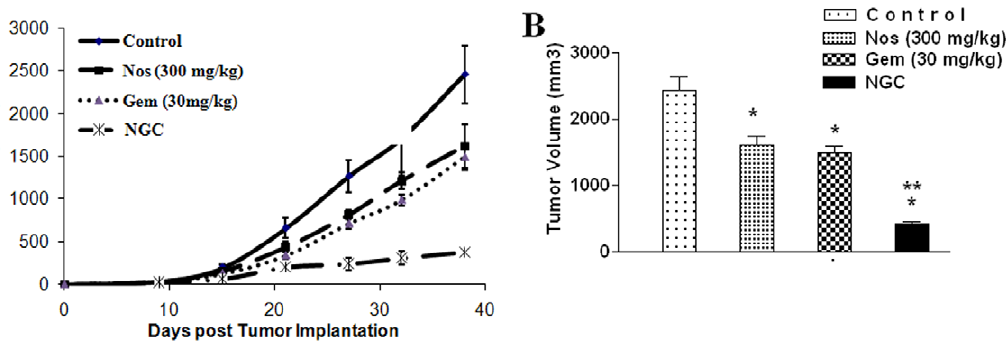
Figure 3. Effects of Nos, Gem and NGC on human H460 lung tumor xenograft model (A) progression profile of tumor growth kinetics and (B) tumor volume measurements on days 38 post-inoculation (tumor volumes, mm3 ± SEM). The mice were treated with Gem 30 mg/kg i.v. bolus, q3d 6 7 schedule, Nos 300 mg/kg/day, and NGC. Control group received vehicle only. Data presented are means and SE (n=8). This experiment was repeated twice.